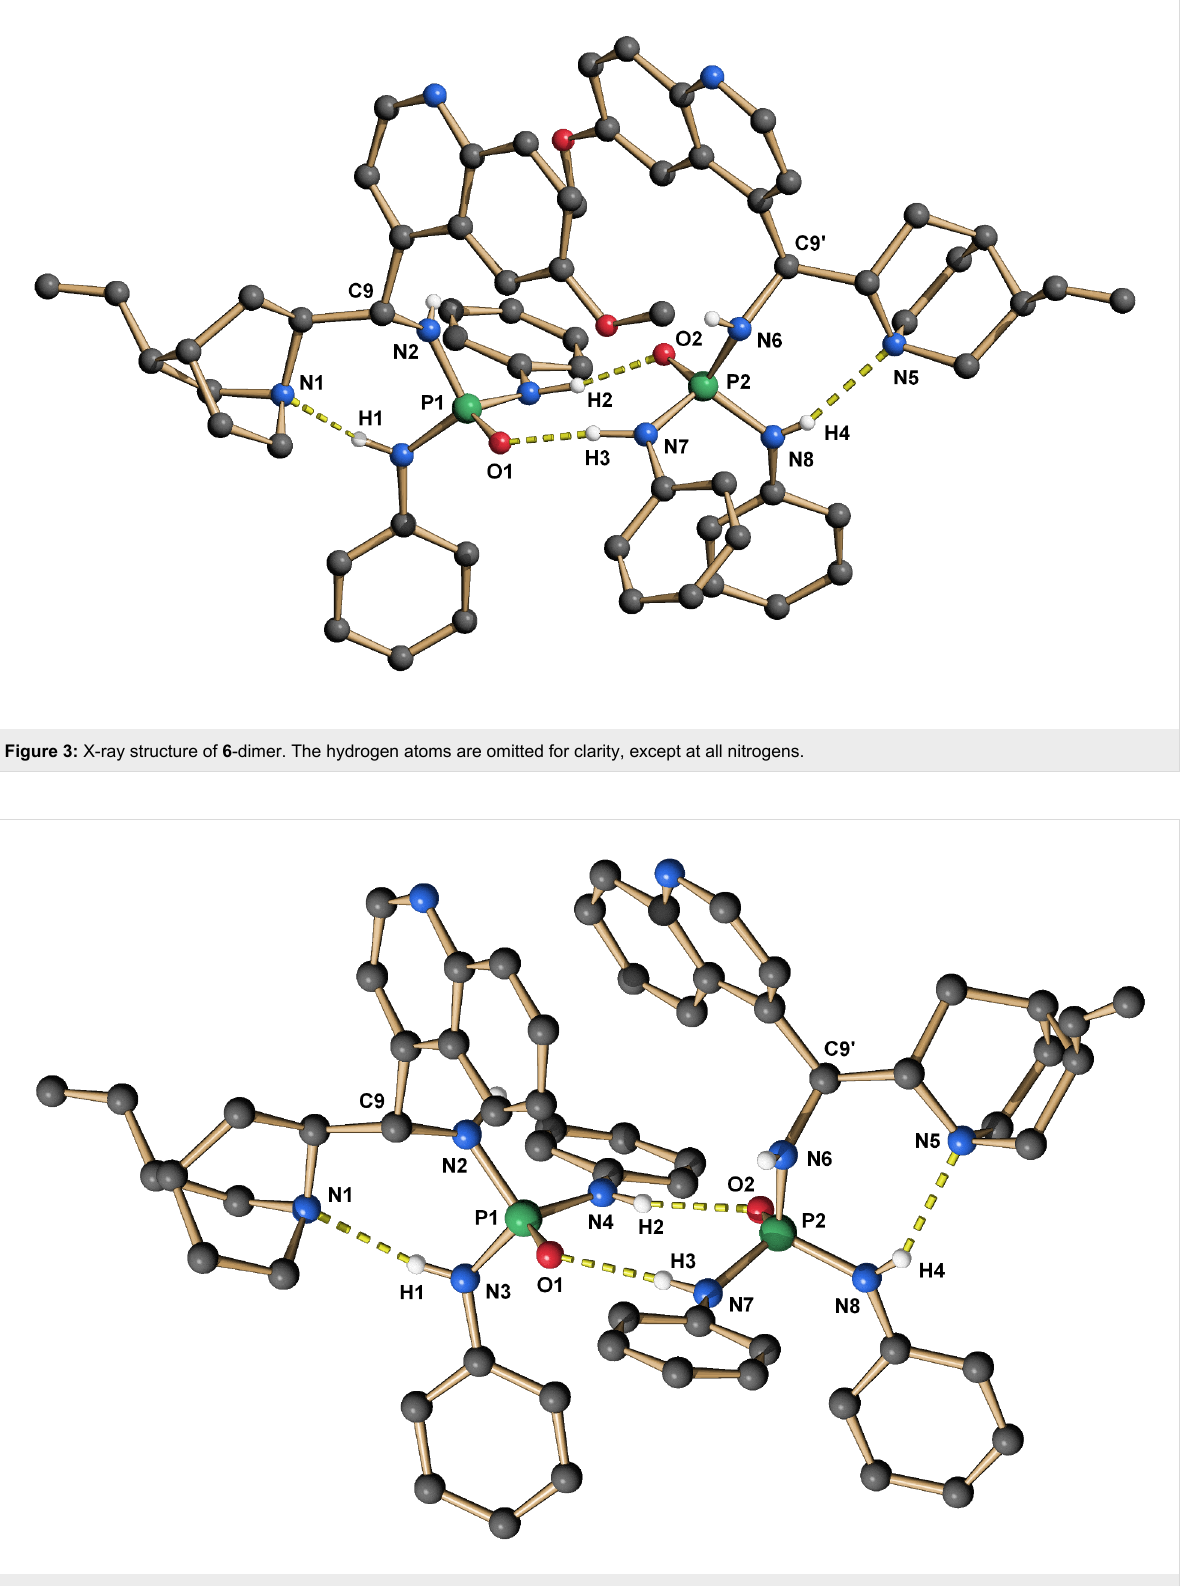
Figure 4: X-ray structure of 7a -dimer. The hydrogen atoms are omitted for clarity, except at all